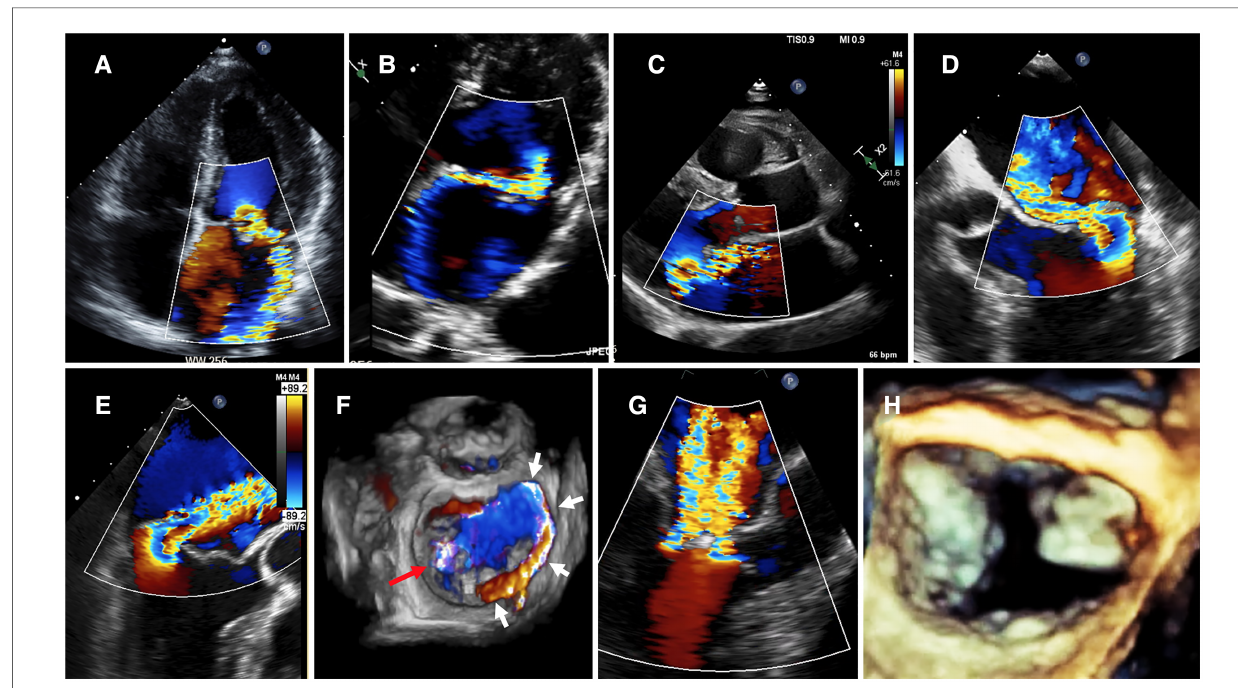
FIGURE 3 Doppler color approach of primary MR evaluation. ( A ) Anterior MV prolapse with eccentric MR jet impinging on the posterior LA wall because of Coanda ̆ effect. The direction of the MR jet helps in understanding the prolapse ’ s mechanism. ( B ) Posterior MV prolapse with eccentric jet impinging on the interatrial septum down to the pulmonary veins. Despite a small color fl ow jet area, a signi fi cant MR should be suspected because of the presence of a Coanda ̆ effect. ( C ) Posterior MV prolapse with large spontaneous proximal fl ow convergence (i.e without modifying Doppler color settings). A signi fi cant MR should be suspected. ( D,E ) Examples of posterior MV fl ail by TEE where the 3 components of the MR are clearly visualized (proximal fl ow convergence, vena contracta and distal MR jet). Hence, it is possible to measure 2D-vena contracta width. However, it should be kept in mind that the measurement of 2D-VCW could be less reliable when performed orthogonal to the direction of the ultrasound beam because of lower lateral than axial resolution. ( F ) Surgical “ en face ” view with Doppler color mode. A full MV 3D color-coded data set can objectively document MR regurgitant(s) jet(s). However, this method could suffer from markedly decreased framerate, therefore multi-beat acquisition is usually required to obtain an acceptable quality imaging. Herein, the origin of the MR is visualized at the MV anterior commissure (red arrow), and the distal MR jet is impinging on the inter-atrial septal wall because of the Coanda ̆ effect. ( G,H ) Double MR jet with a pattern of “ Crossed swords sign ” . 3D-TEE imaging revealed a large anterior cleft indentation. 3D, three-dimensional; LA, left atrium; MR, mitral regurgitation; MV, mitral valve; TEE,